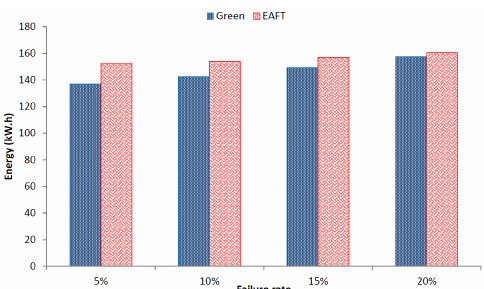
Figure 7. Impact of Failure on Energy Consumption.